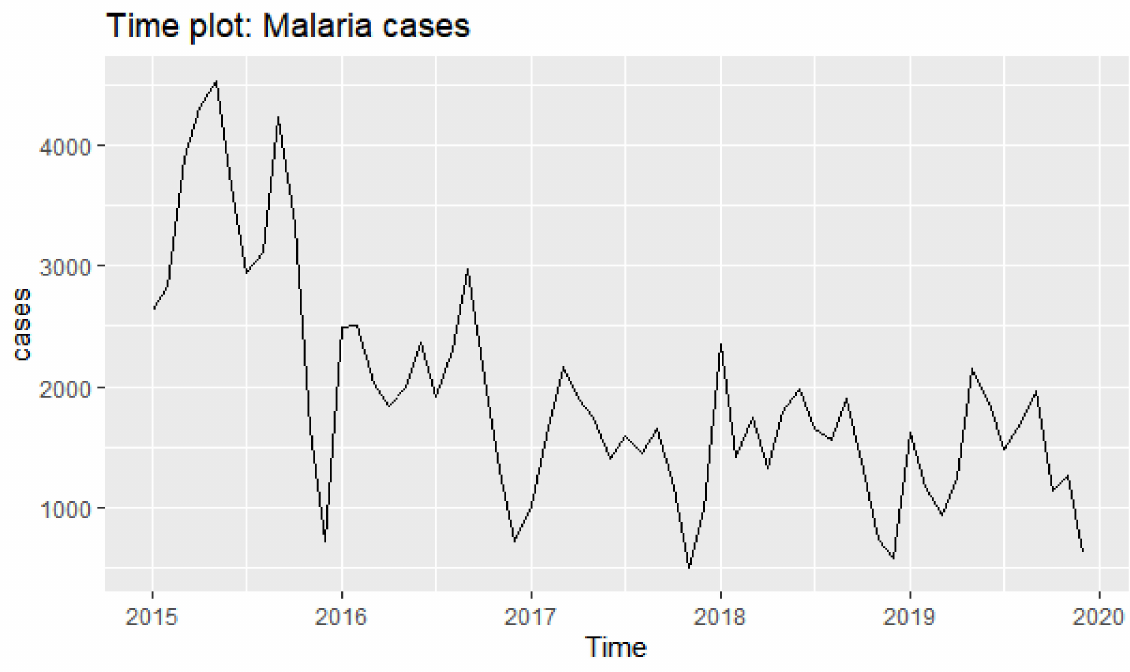
Figure 4. Time diagram for case incidence of malaria